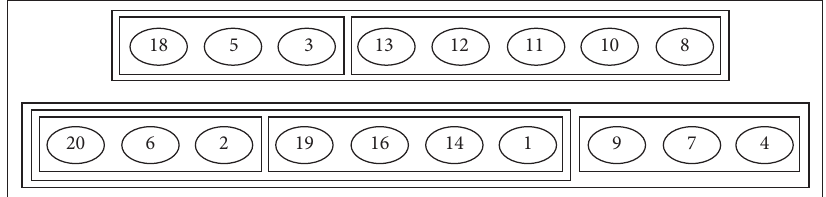
Figure 14: The flat